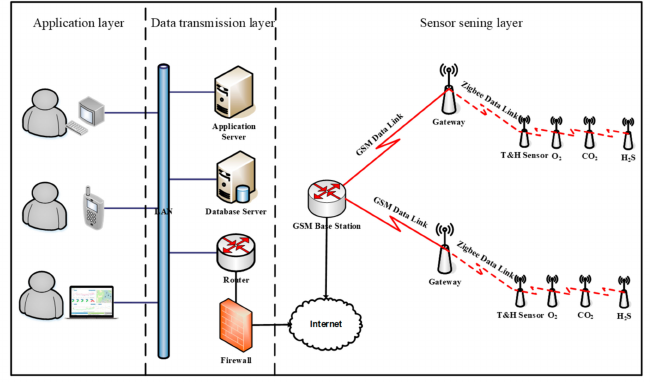
Figure 1. The architecture of IoT-enabled monitoring system (IoTMS). Note: Local Area Network (LAN), Temperature &Relative humidity (Tem&RH).